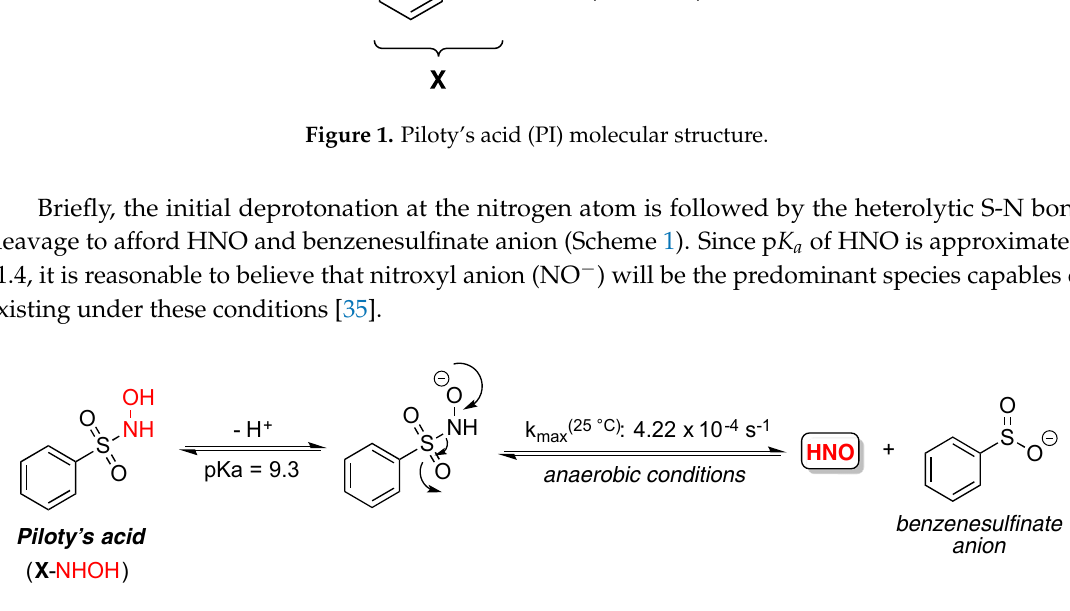
Scheme 1. Mechanism proposed for the spontaneous decomposition of Piloty’s acid (PI) in strongly